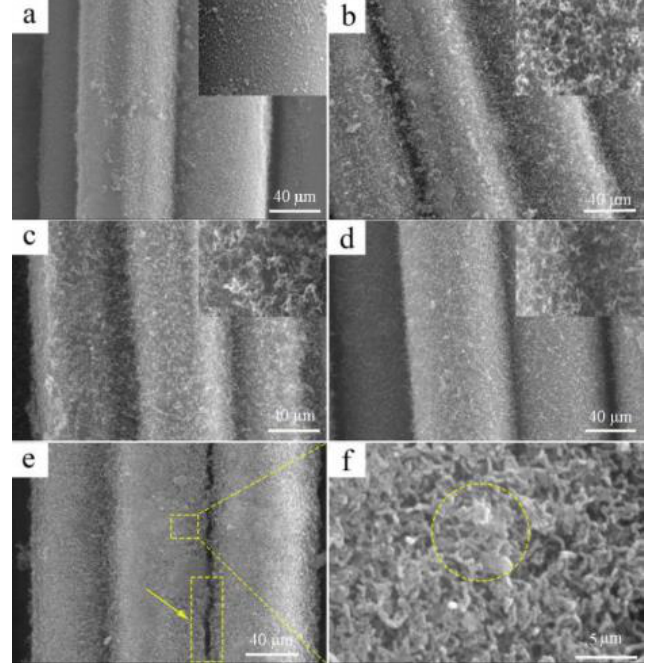
Figure 3. SEM micrographs of CNTs/carbon fiber (CF) multiscale reinforcements prepared at different moving speeds: ( a ) 10 cm/min; ( b ) 6 cm/min; ( c ) 4 cm/min; ( d ) 3 cm/min; ( e ) 2 cm/min and ( f ) the expanding image of ( e ). The flow rate of H 2 and C 2 H 2 was 0.3 L/min.